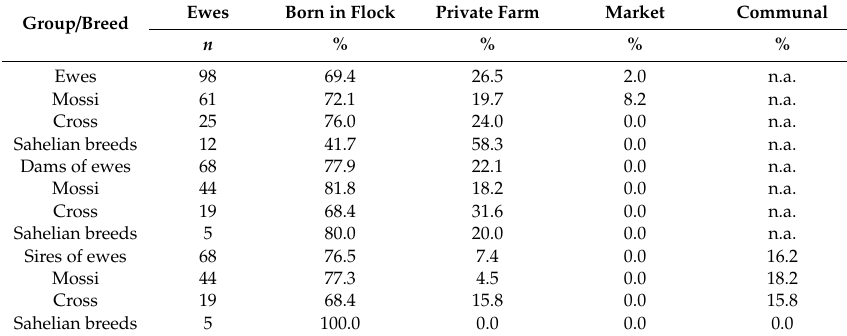
Table 7. Source of ewes 1 and ewes’ sires and dams owned by sheep breeders in Ouagadougou ( n = 31). Group / Breed